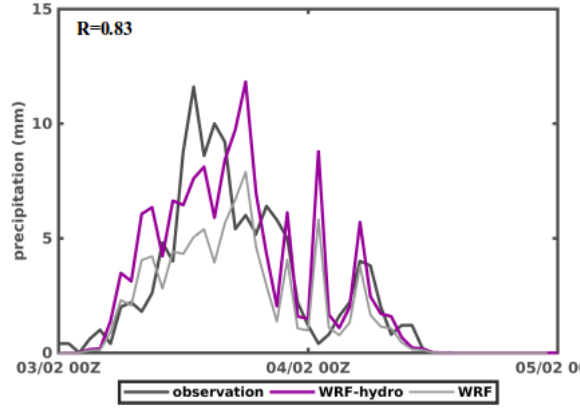
Figure 6. The temporal evolution of the precipitation at the rain gauge station at N. Makri for event